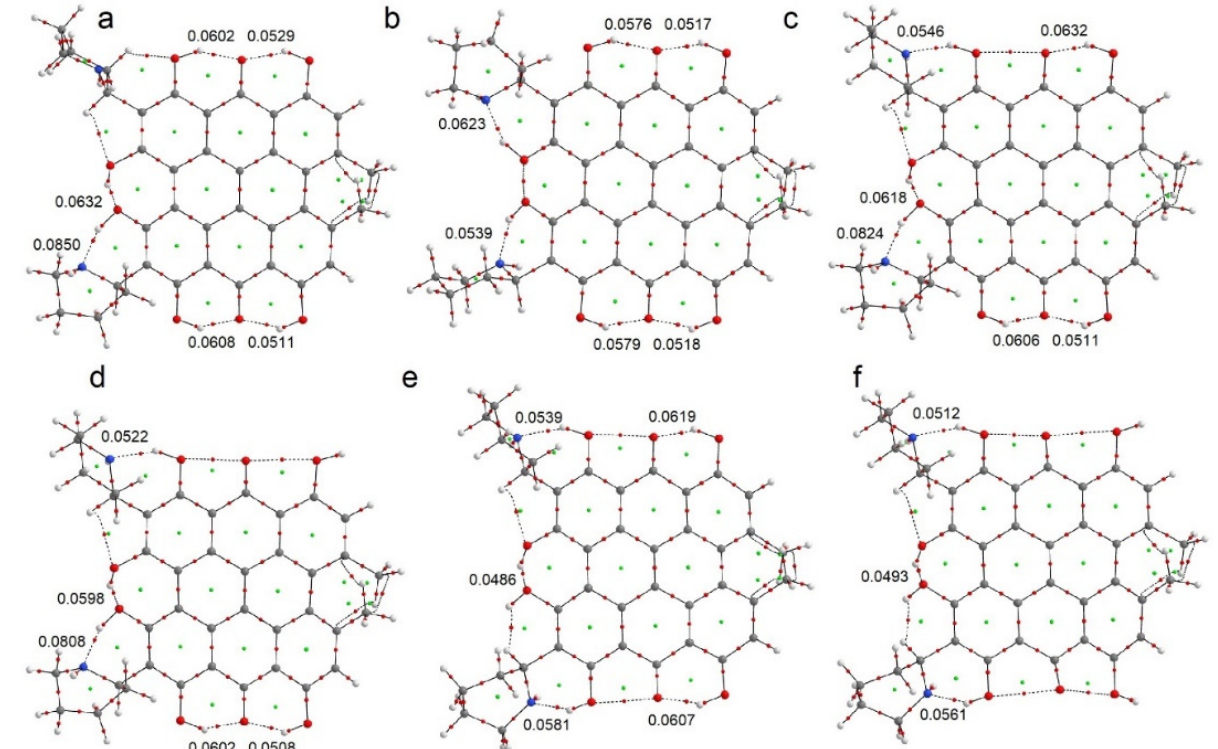
Figure 8. QTAIM plots for ( a ) 31, ( b ) 32, ( c ) 33, ( d ) 34, ( e ) 35, and ( f ) 36 fagopyrin F conformers. Green points correspond to RCPs. Red points indicate BCPs.